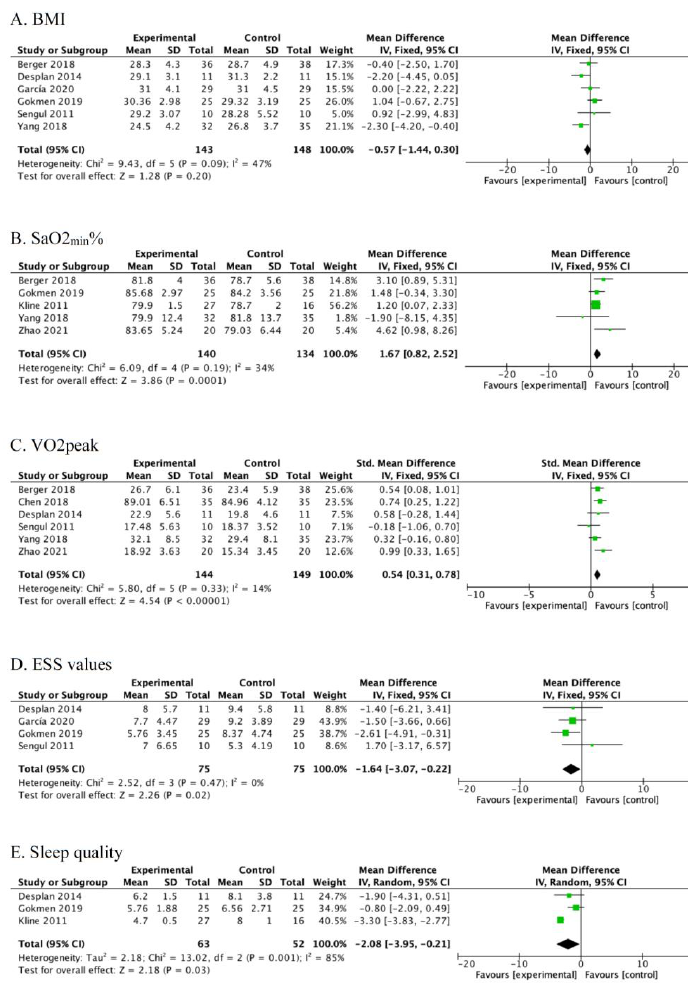
Figure 4. Meta-analysis of the pooled effect of exercise training on BMI ( A ), SaO2min% ( B ), VO2peak ( C ), ESS values ( D ), and sleep quality ( E ) [26 –